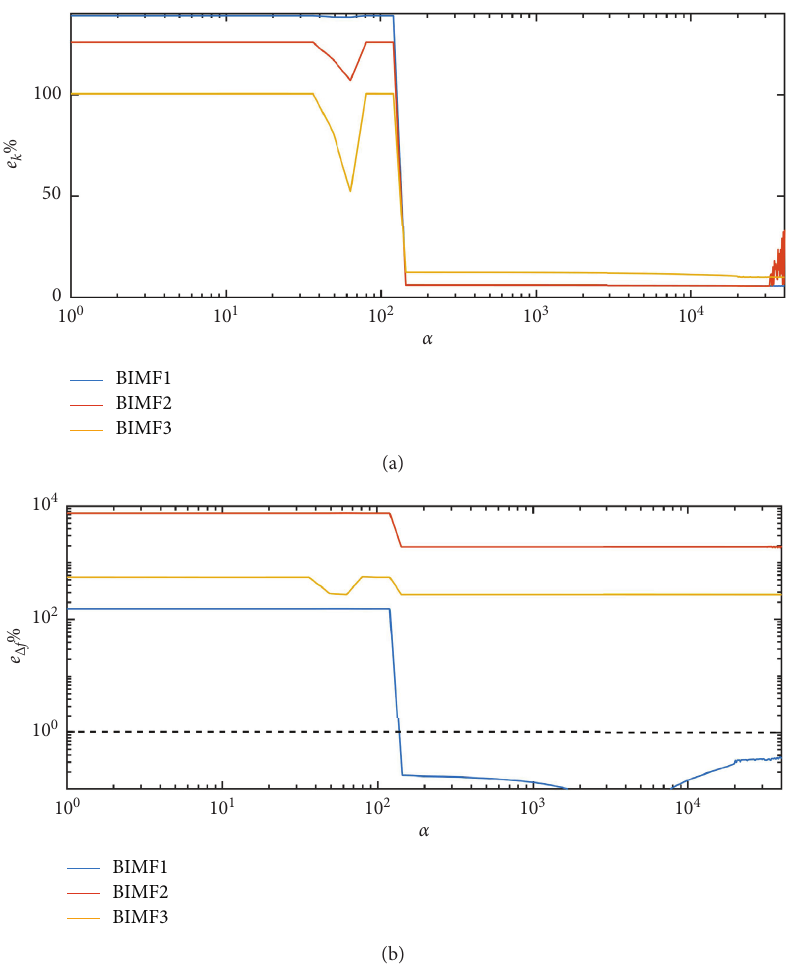
Figure 4: The performances of VMD decomposition results under different penalty